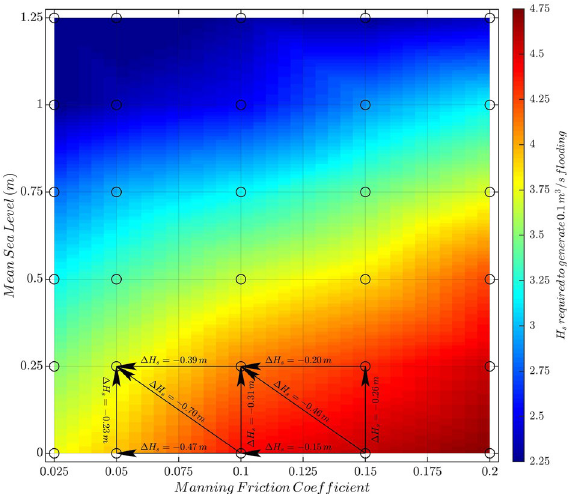
Figure 6. Median significant wave height (median value computed using all reef lengths, island heights and 3 peak periods) required to generate a flooding larger than 0.1 m /s as a function of Manning friction coefficient (x axis) and mean sea level (y axis). The colourplot is a bi-linear interpolation from the 30 values (black dots) obtained from the numerical simulations. Arrows indicate the H s change when moving between the two indicated combinations of Manning value and mean sea